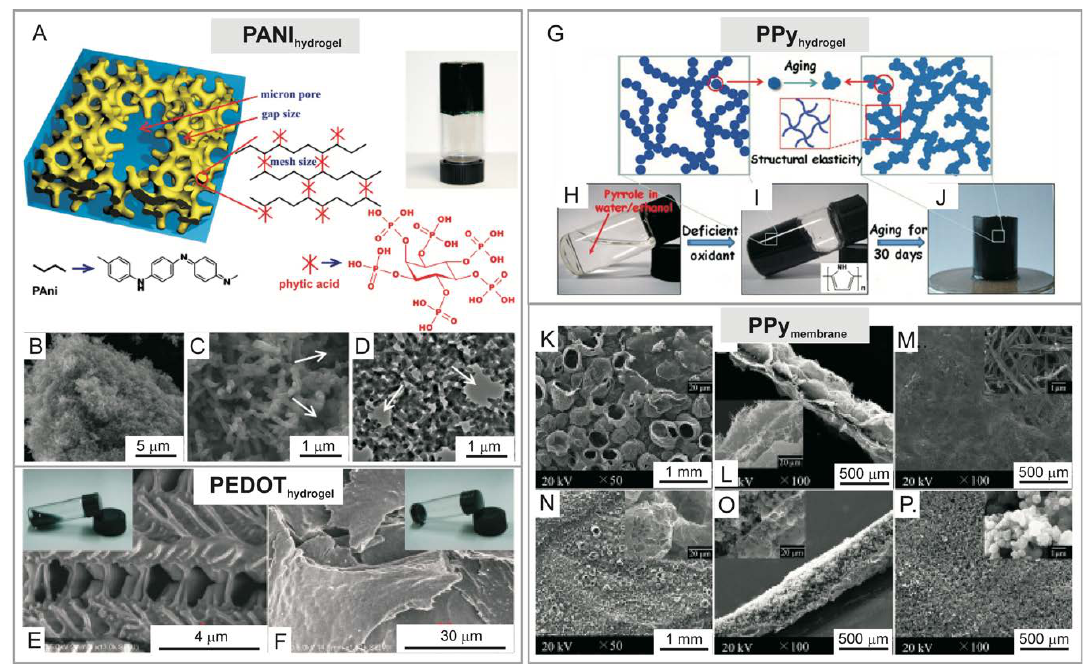
Figure 1. ( A ) Chemical structure and morphological characterization of phytic acid-gelated and doped PANI hydrogel . A photograph of PANI hydrogel inside a glass vial. ( B – D ) Scanning electron microscopic (SEM) images and transmission electron microscopic image of PANI hydrogel [141]. ( E , F ) SEM images of PEDOT hydrogel morphology synthesized in the presence of different oxidants [147]. ( G ) Schematic illustration of the synthesis of PPy hydrogel via chemical oxidation. Photographs of ( H , I ) synthesis of PPy hydrogel inside glass vials and ( J ) formed PPy hydrogel [148]. ( K – P ) SEM images of PPy membrane synthesized by template-assisted polymerization [149]. Reprinted with permission from References [141,147–149]. Copyright 2019 PNAS, Nature Group, Royal Society of Chemistry and